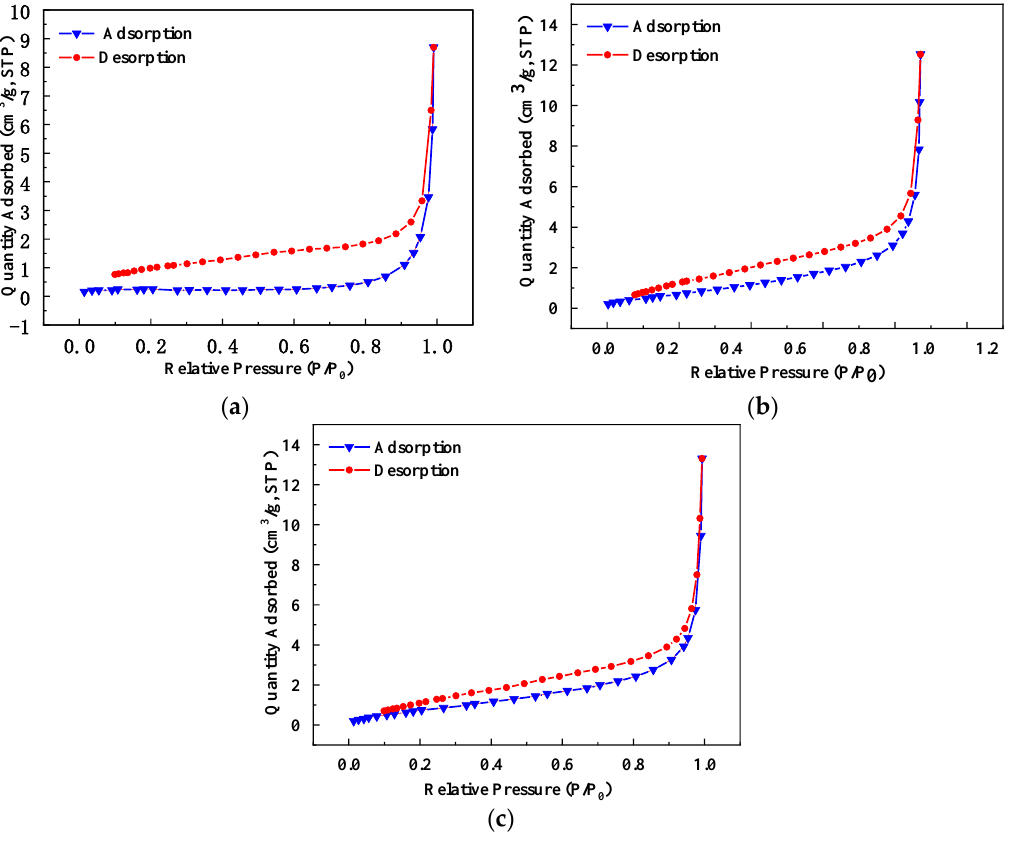
Figure 4. Adsorption/desorption equilibrium curves of liquid nitrogen on coal samples with different grinding times. ( a ) 0 min, ( b ) 10 min, ( c ) 20 min. Table 4. Specific surface area and porosity test results of coal